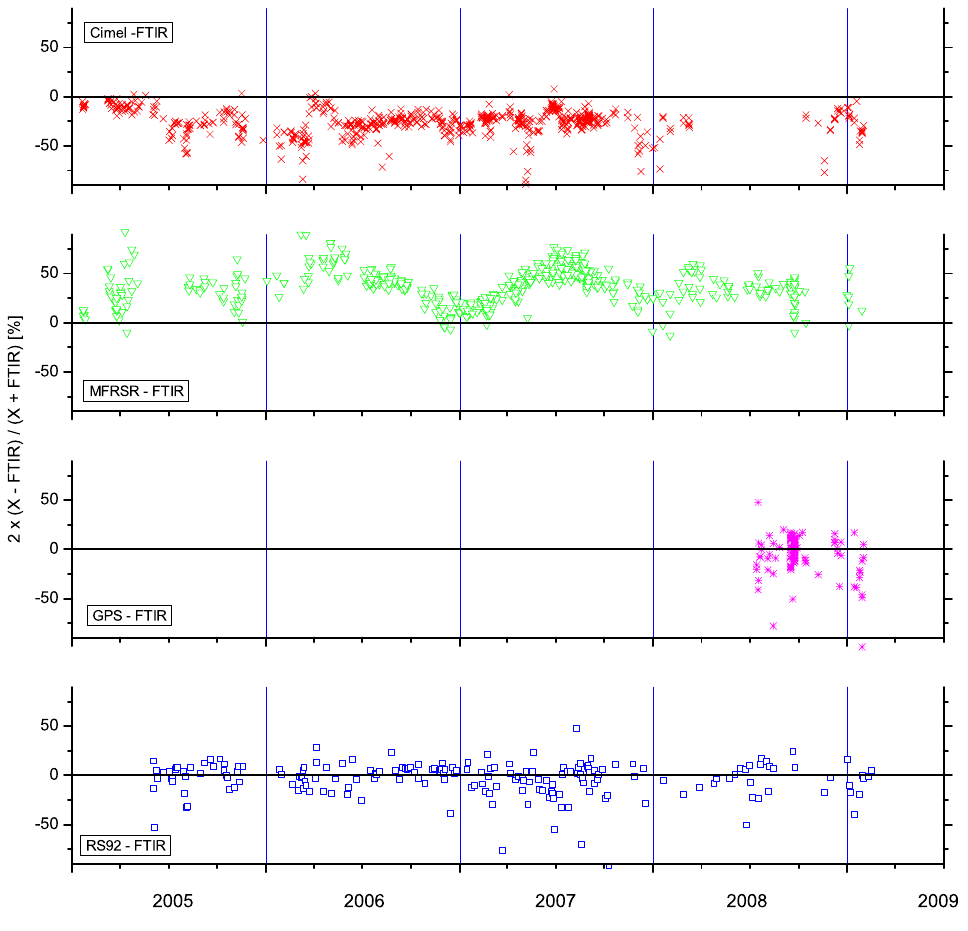
× ( X − FTIR ) ), where X is Cimel, MFRSR, GPS and RS92, as ( X + FTIR )